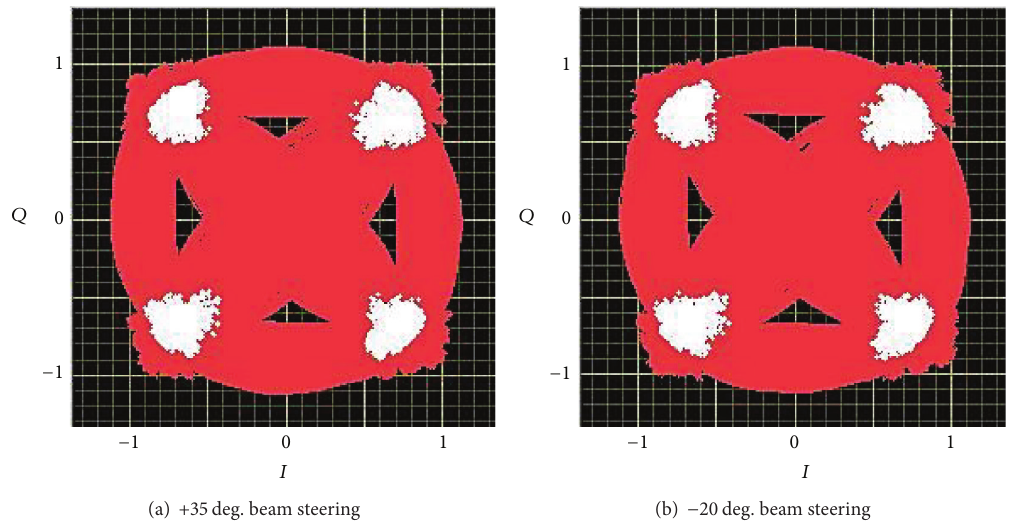
Figure 9: Measured constellations of the received IF signals when the beam is steered.